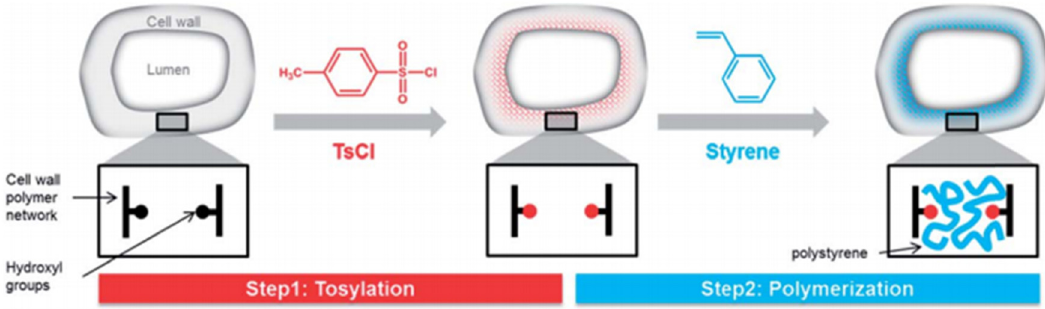
Figure 11: Schematic representation of the modi fi cation route: functionalization of cell wall – OH groups with tosyl groups, followed by in situ polymerization of the styrene monomer [ 107 ] .